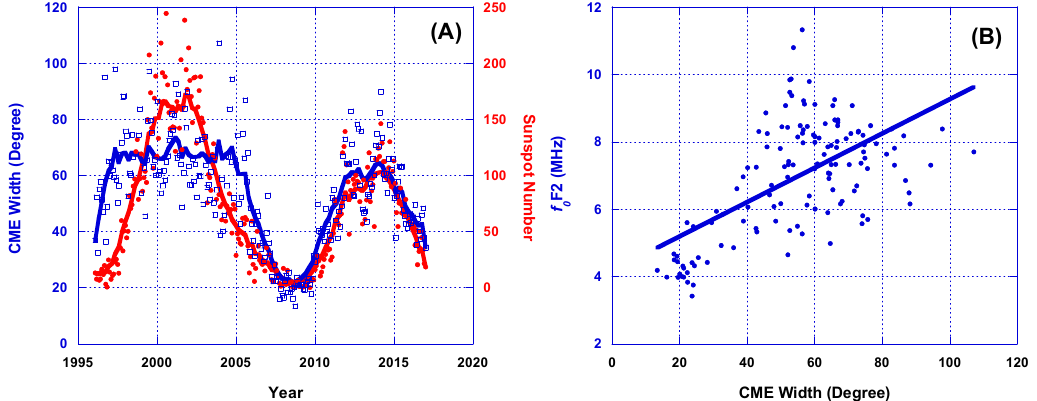
Figure 2 . The time series of the monthly average values of the coronal mass ejections (CMEs) angular widths (in degrees) and that of the sunspot number (SSN) ( A ), and the relationship between monthly average value of f 0 F2 values and the monthly average CMEs widths ( B ). The blue color of the left axis values, smooth curve and square points of plot ( A ) refer to the CME’s width, while the red color of the right axis values, smooth curve, and round points denote to the sunspot numbers.